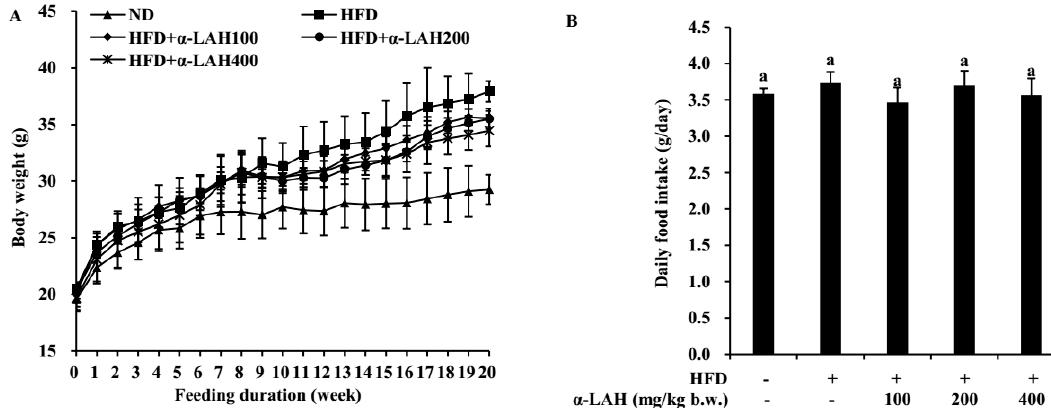
Figure 1. Effect of bovine α -lactalbumin hydrolysates ( α -LAH) supplementation on body weight and food intake in mice fed with high-fat diet. ( A ) Changes in body weight through the experimental period; ( B ) Daily food intake. All data were presented as means ± standard deviations (SD) ( n = 10). Significance was determined by one-way analysis of variance (ANOVA) with the Duncan’s multiple-comparison test, and mean values without common letters indicate differences at p < 0.05.